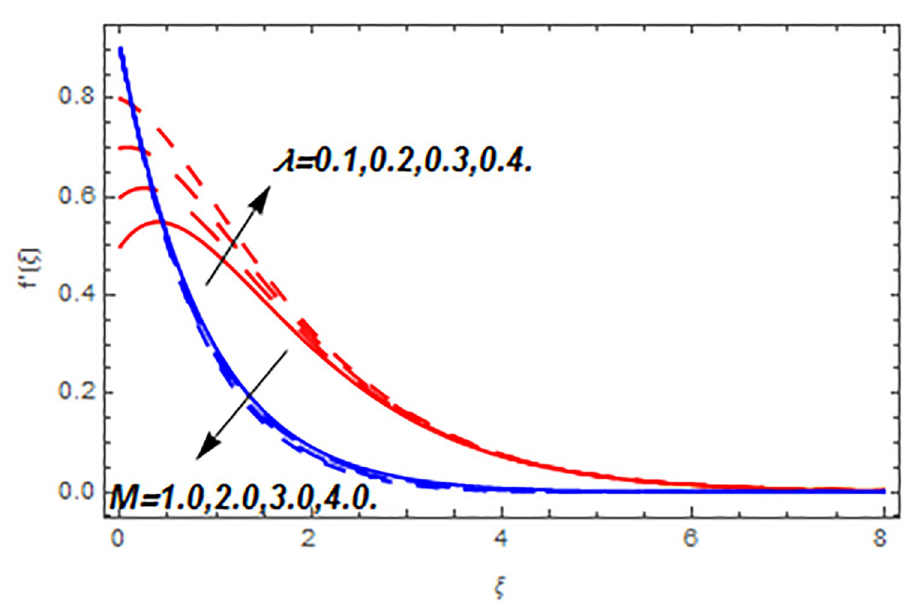
Fig 4. Flow profiles versus magnetic and stretching parameters.